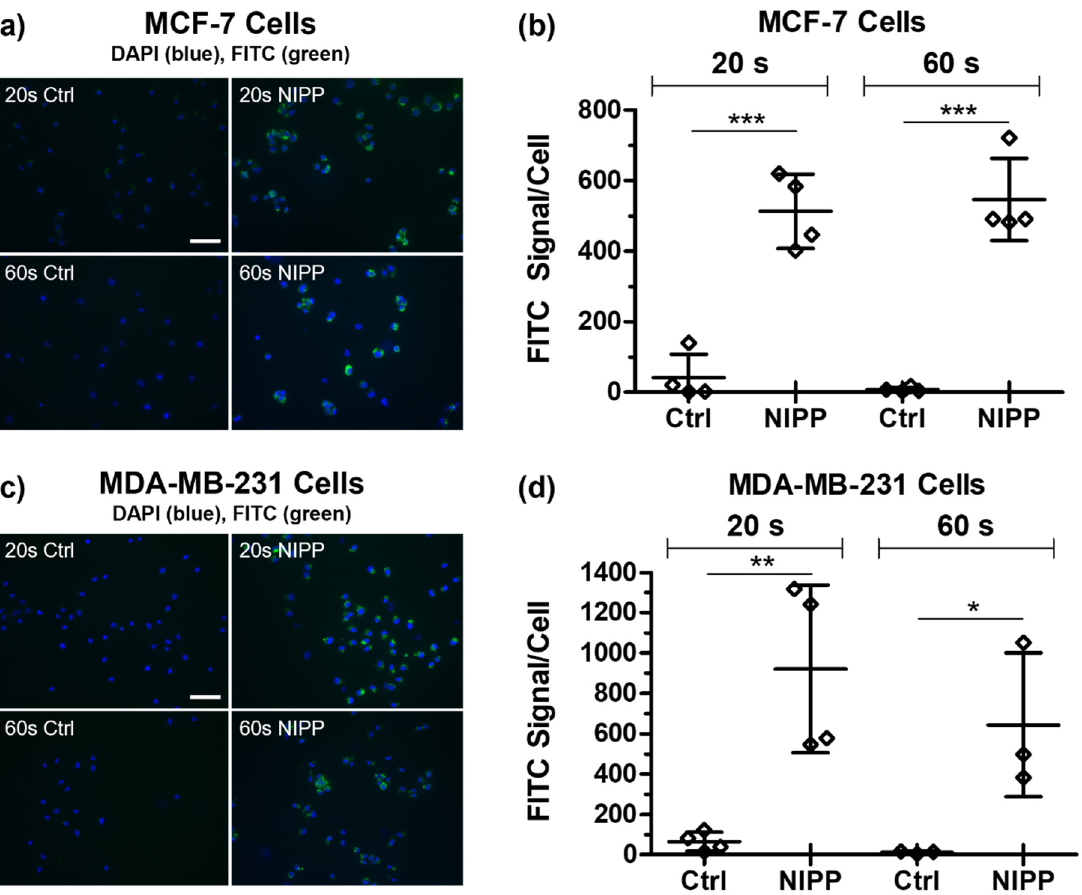
Figure 4. Microscopic dextran-fluorescein isothiocyanate (FITC) uptake assay. Breast cancer cells MCF-7 ( a , b ) and MDA-MB-231 ( c , d ) were seeded on coverslips, treated with NIPP for 20 and 60 s, and stained with 10 µ L of dextran-FITC and 100 µ L DAPI for 2 min. Cells were analyzed by fluorescence microscopy (BZ-9000 microscope with BZ-II analyzer software, scale bars represent 50 µ m). For analysis, the FITC-positive area was determined and correlated to the number of DAPI-positive nuclei (FITC signal/cell). The results are displayed as mean ± standard deviation ( p ≤ 0.05 *; p ≤ 0.01 **; p ≤ 0.001 ***).